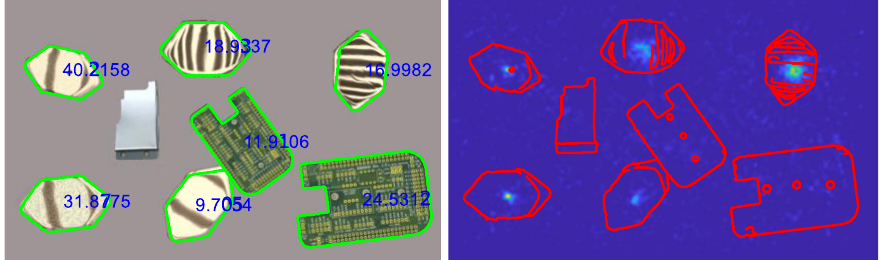
Figure 12. Multi-instance positioning results for shapes T1 and T4 ( left ) and the centre votes’ response ( right